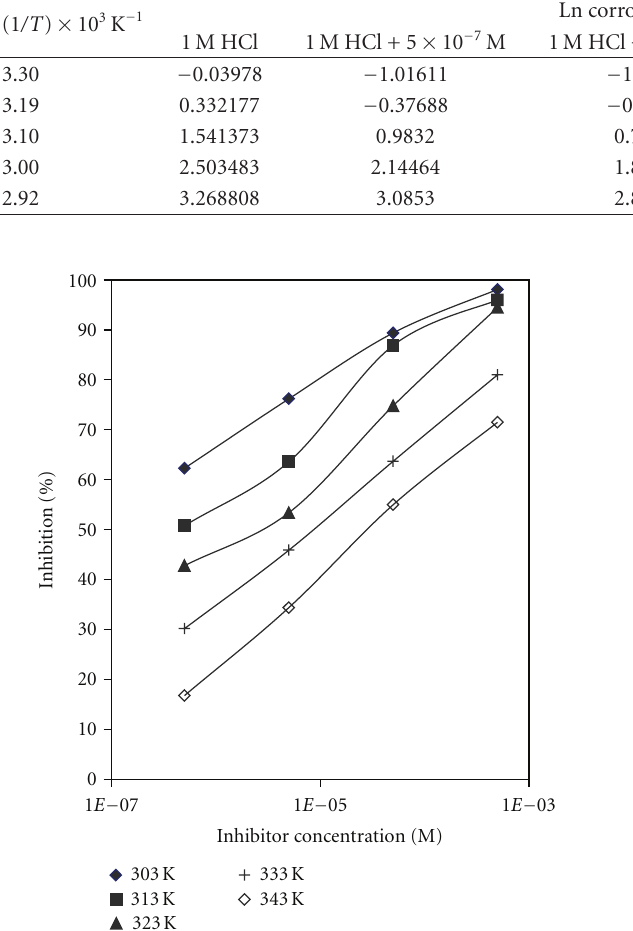
Figure 7: E ff ect of temperature on the corrosion rate of mild steel in 1.0 M HCl solution with and without the presence of various concentrations of 3-benzoylmethyl benzimidazolium hexafluoroantimonate